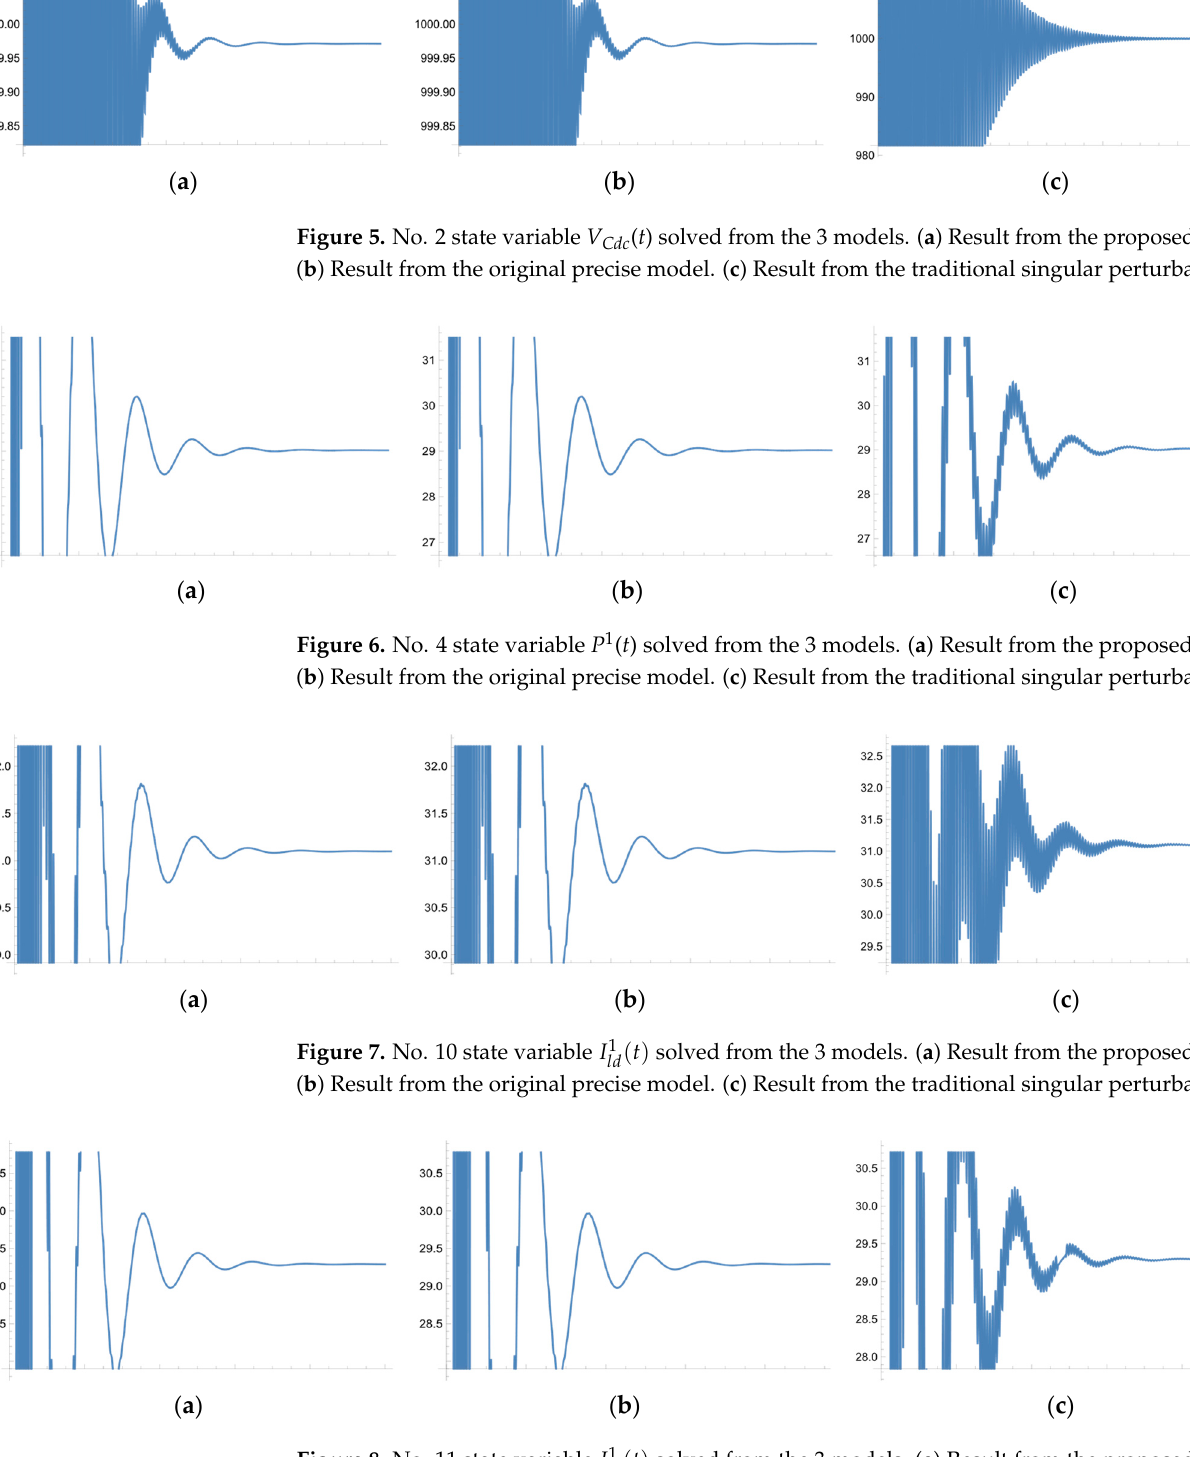
Figure 8. No. 11 state variable I lq 1 ( t ) solved from the 3 models. ( a ) Result from the proposed method, ( b ) Result from the original precise model. ( c ) Result from the traditional singular perturbation.